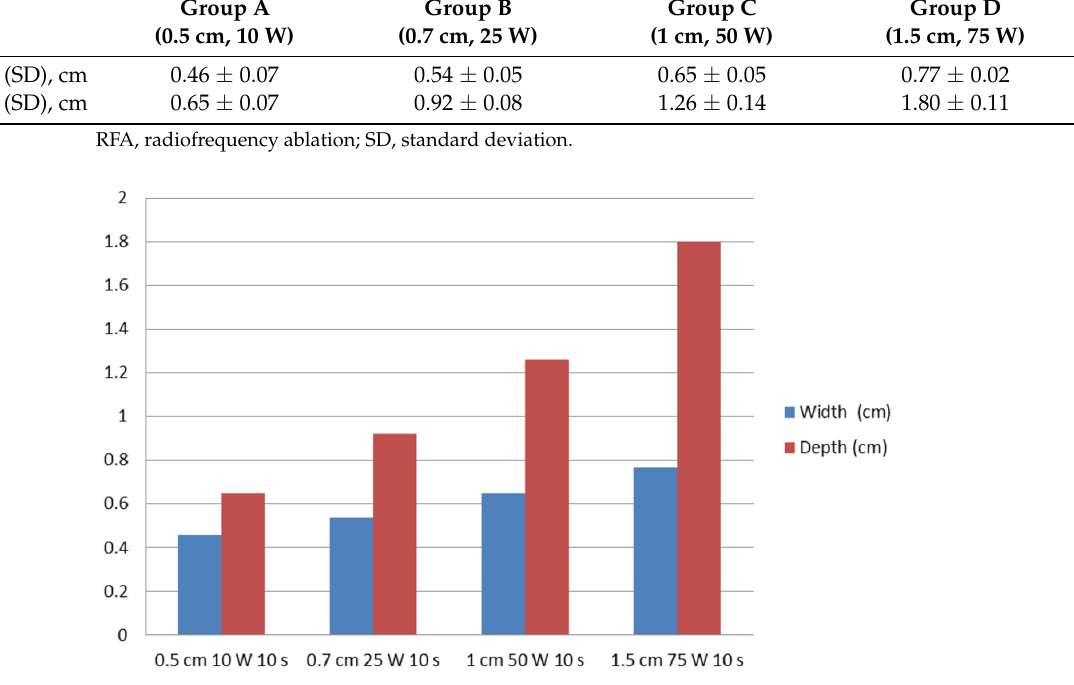
Figure 3. Relationships of ablation effect on probe tip length and RFA power. The vertical axis rep- resents the width (cm) and depth (cm) of ablation zones.